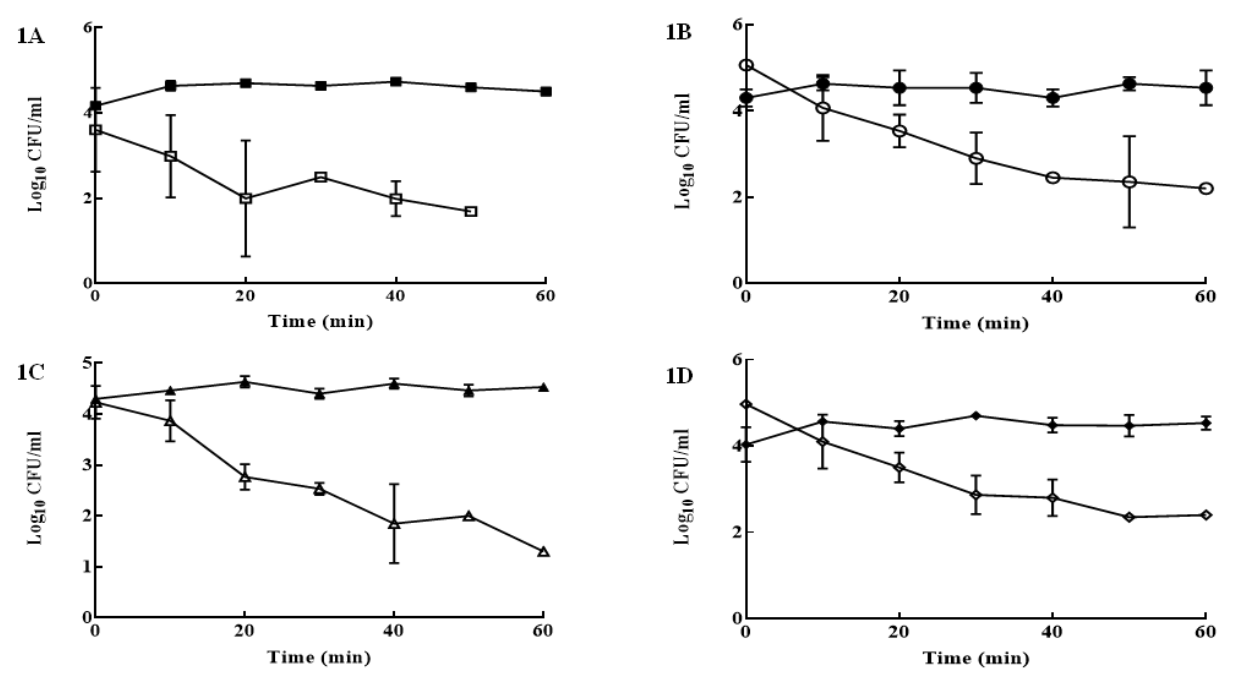
Figure 1 . Sporicidal effect of 10% v/v treatment 1 at 0, 10, 20, 30, 40, 50 and 60 min contact times for Figure 1. Sporicidal effect of 10% v / v treatment 1 at 0, 10, 20, 30, 40, 50 and 60 min contact times